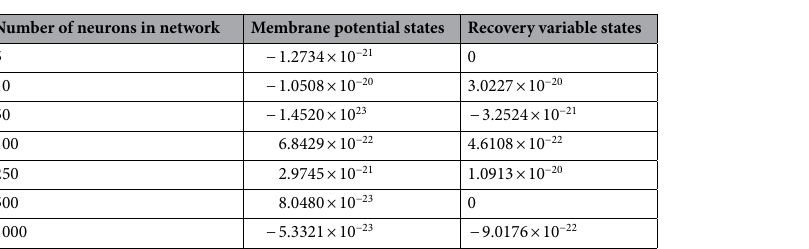
Table 2. Mean errors in the synchronization dynamics of the membrane potential states and recovery variable states for different-sized unidirectional networks of FHN neurons without noise.